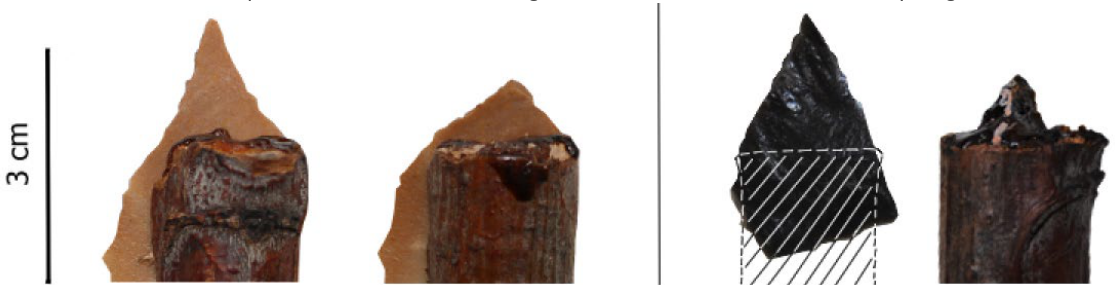
Figure 15: Photographs of the two flint drill bits (one of which has been abraded to reduce its diameter), before and after use, as well as of the perforation created. The diameter of the perforation is almost compatible with the archaeological record but these drills are very fragile.